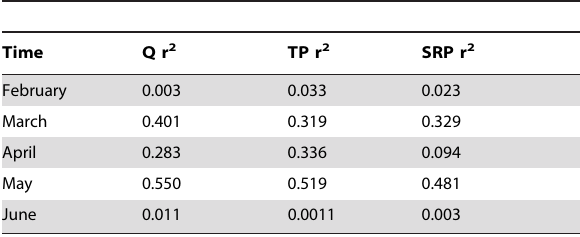
Table 2. R 2 for all 10 years between maximum CI and the load of interest for months with positive